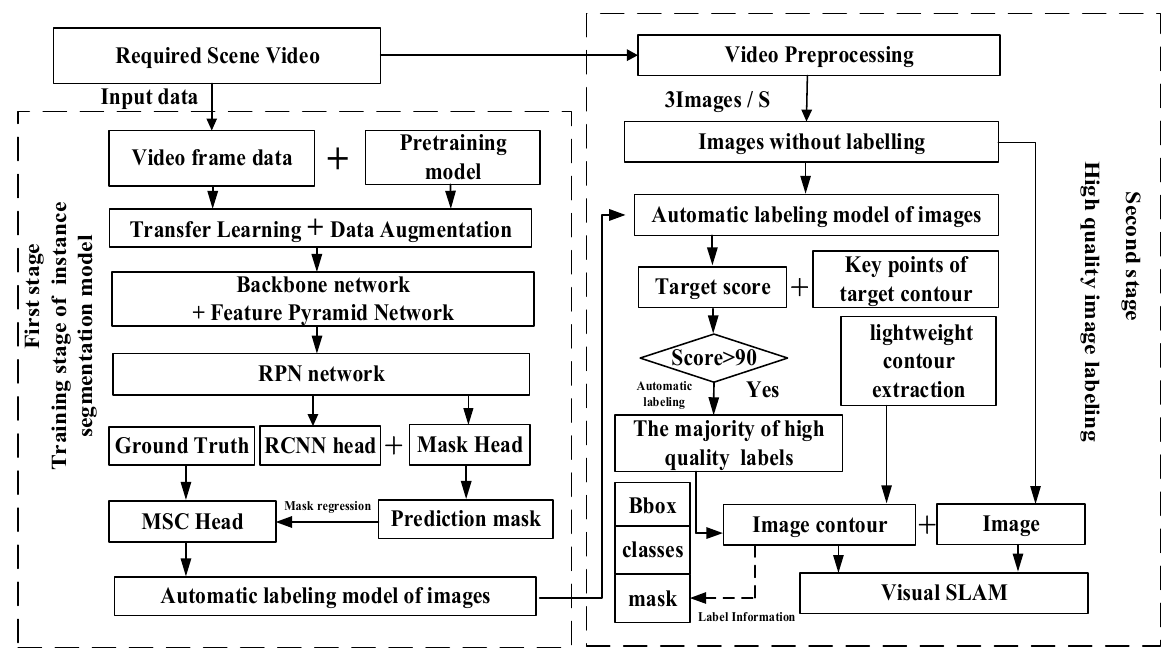
Figure 2. Framework of CO-HDC instance segmentation.